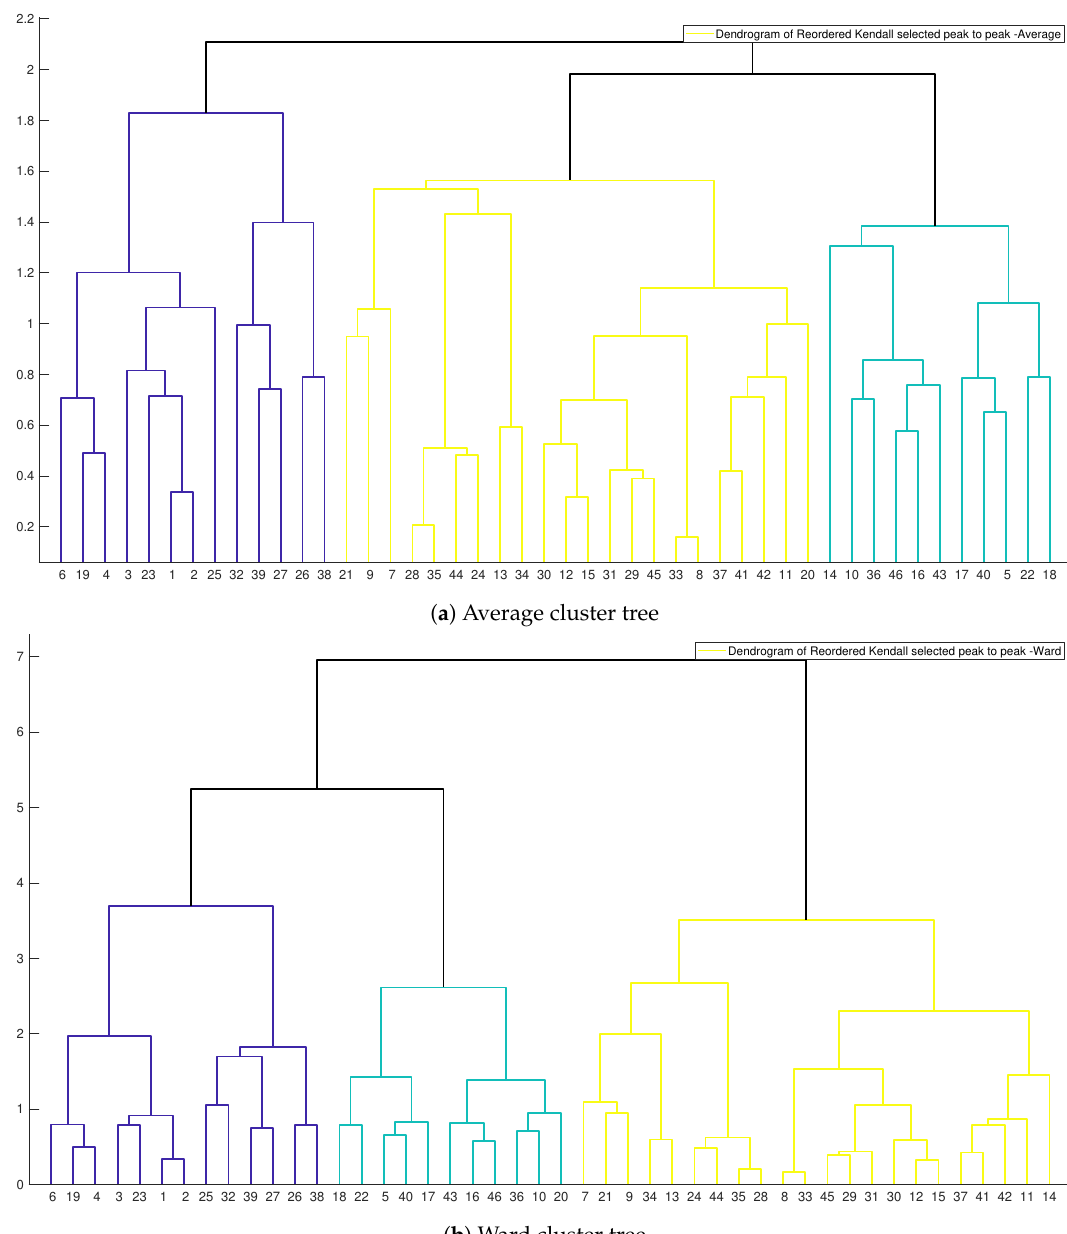
Figure 6. Hierarchical cluster tree of the simultaneous occurrence of the biggest floods. Dendrogram presented similarities between the contemporary peak discharge of the sampling sites. Furthermore, three main clusters in this figure are entirely vivid. However, inside each batch, there are some sub-clusters that illustrated the interconnection of sub- basins in a specific area. To decide which linkage method or corresponding tree is more relevant to this research, and as a result, do the clustering based on that, three verification methods were exerted. The mean of the inconsistency coefficient was inscribed in Table